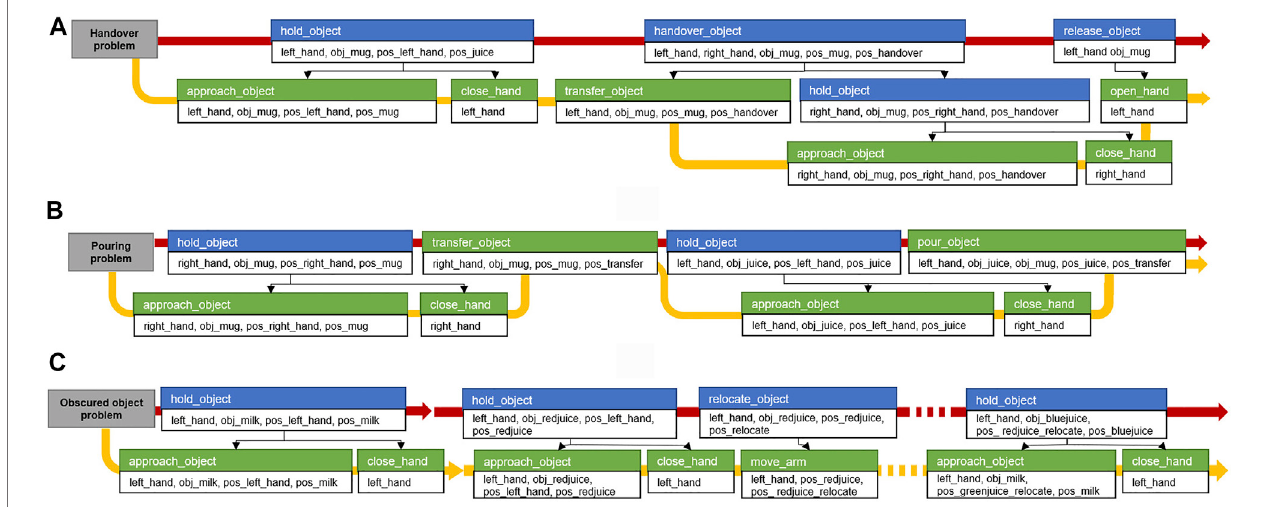
FIGURE 12 | Compound and primitive action sequence from the results of the task planning performed in the three task domains. The blue box is the compound action. The green box is the primitive action. Below are the action parameters. The black arrow indicates the relationship between the compound and primitive actions. The red arrow is thecompound action sequence obtained bythetask planning,and the yellow arrow is theconverted primitive action sequence. (A) Action sequence of the object handover problem. (B) Beverage pouring problem. (C) Obstructed object problem.